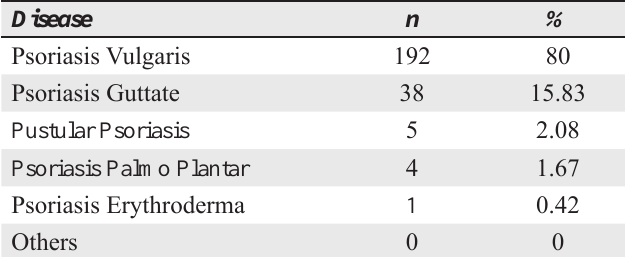
Table 1 : Types of Psoriasis